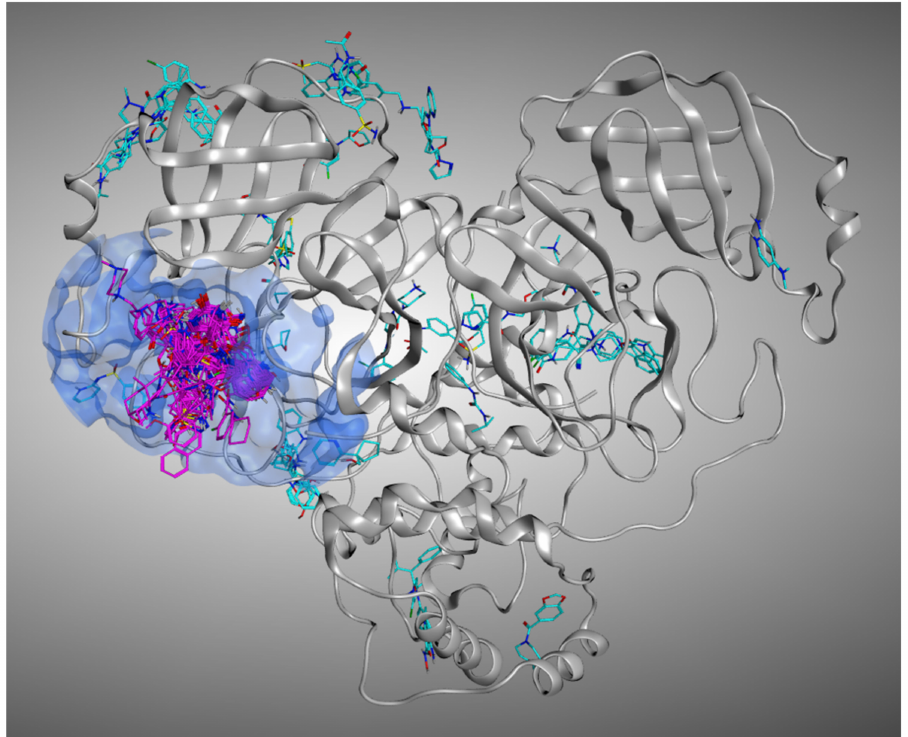
Figure 2. Representation of all the crystallographic ligands of M pro superposed. To give a better view, just one protein structure is represented (the one coming from PDB:7L10). The ligands which are crystallized inside the catalytic pocket are colored in magenta, while all the small molecules crystallized outside the orthosteric binding site are colored in